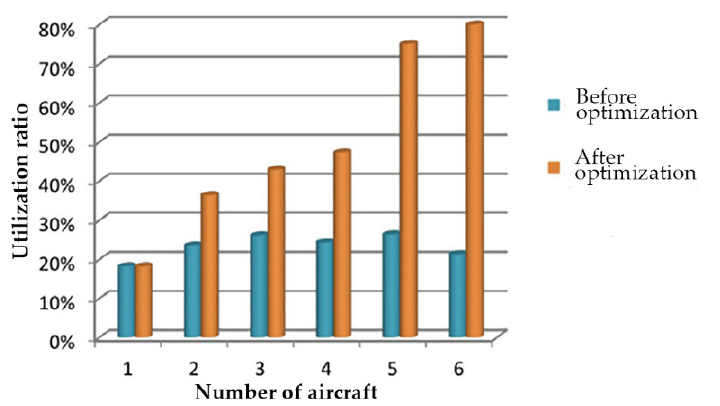
Figure 9. The relationship between the average utilization rate of power vans and the number of support aircraft before and after optimization.